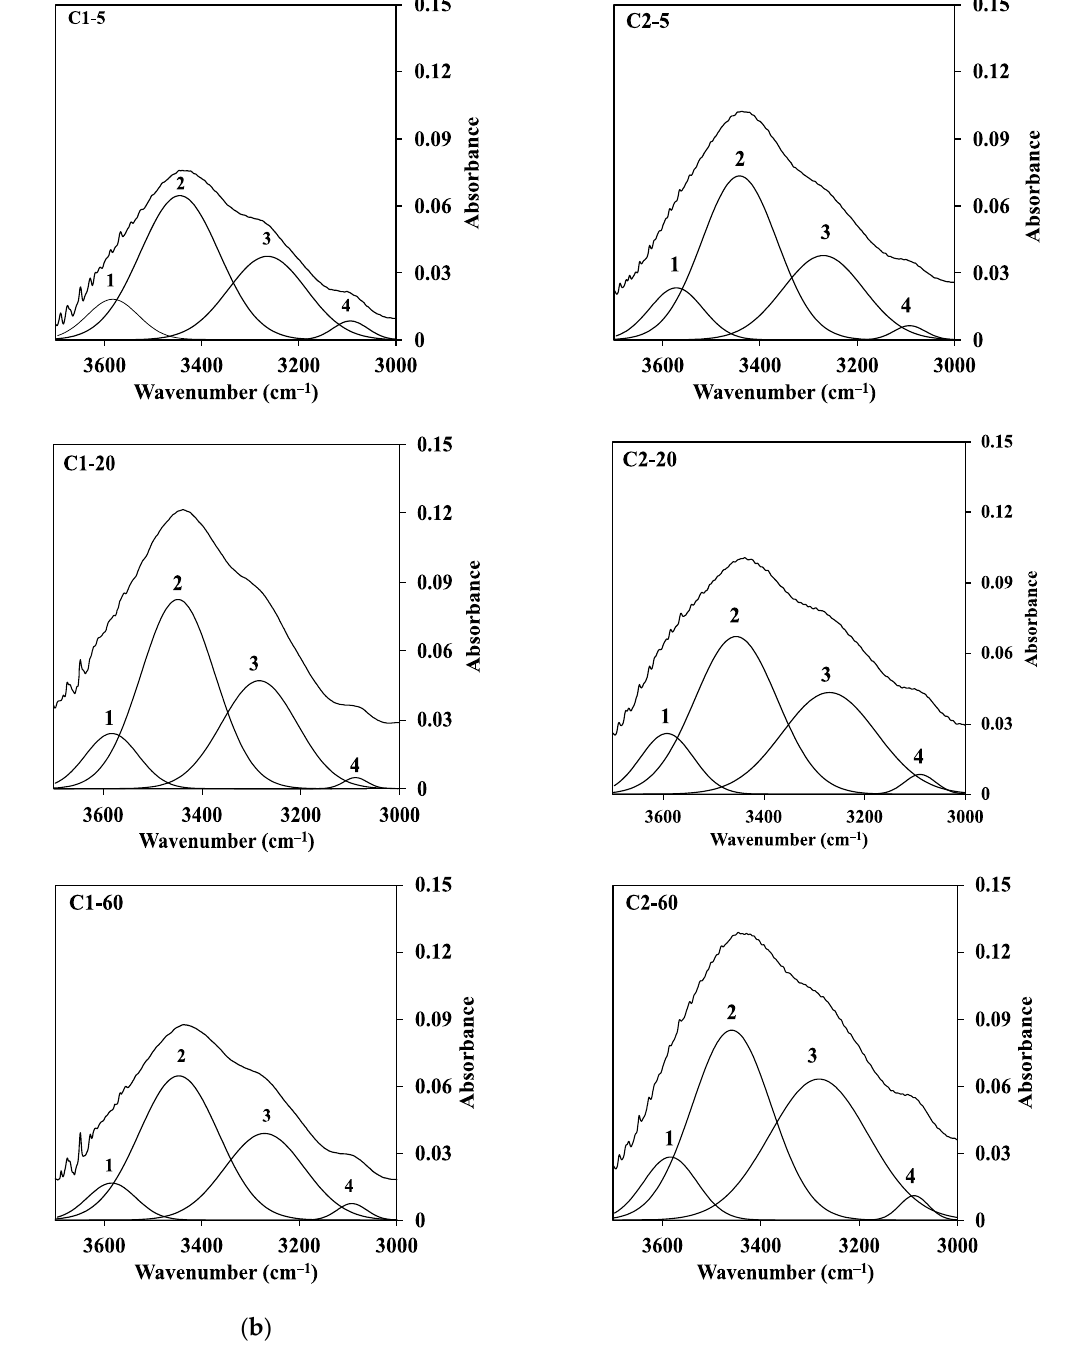
Figure 8. Deconvoluted FTIR spectra in the range of 3700–3000 cm − 1 of the O–H and N–H region for the ( a ) extracted chitin and ( b ) C1.0 (left) and C2.0 (right) fiber obtained at different temperatures of the water coagulation bath. Table 2. Area portion (%) of the hydrogen bonding in the region of 3700–3000 cm − 1 in the deconvo- luted FTIR spectra.